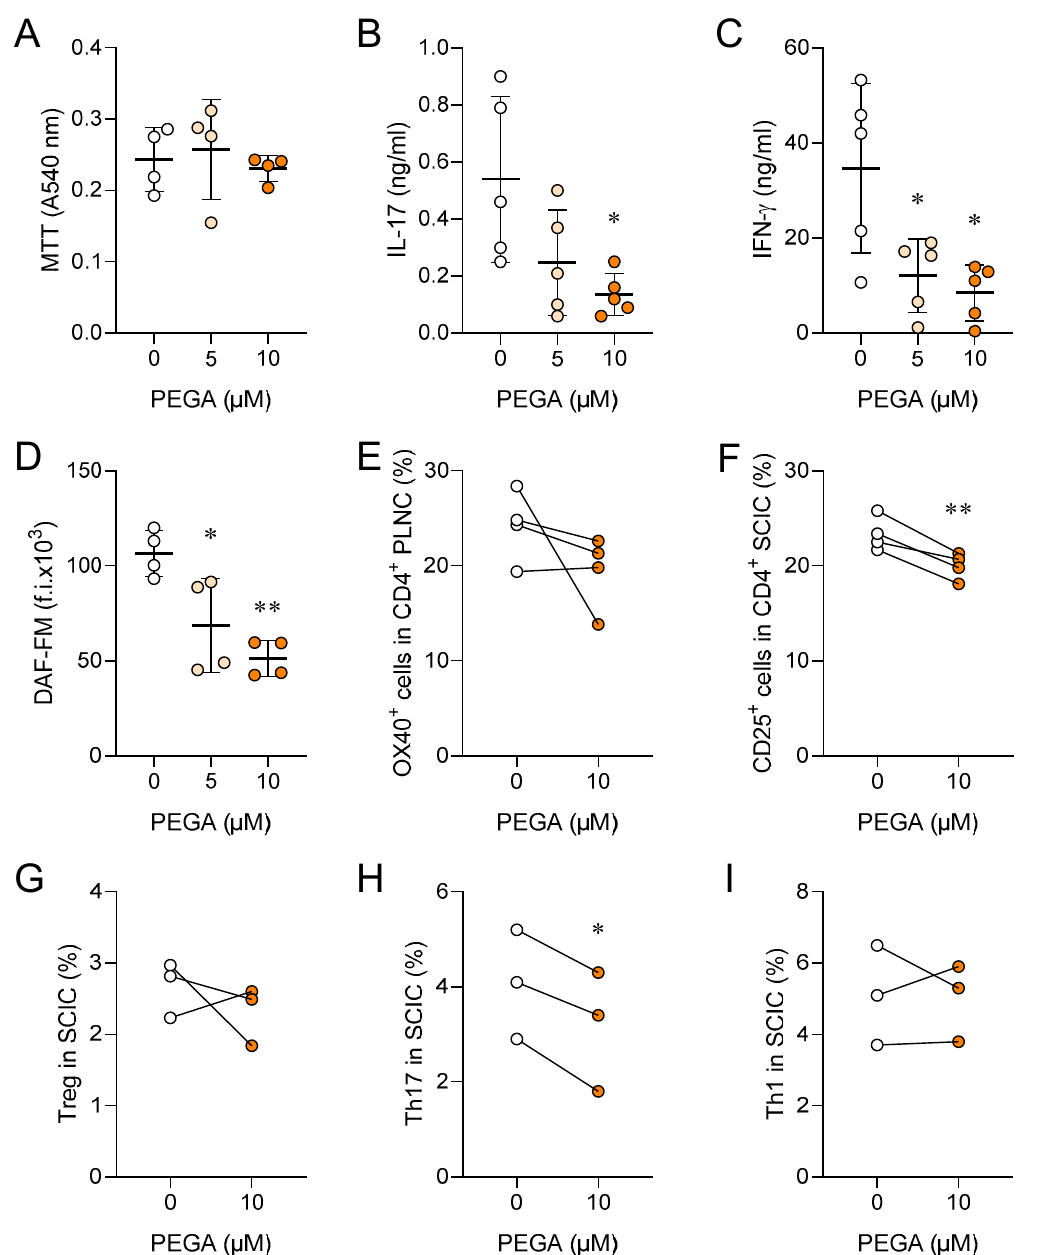
Figure 2. Immunomodulatory effects of PEGA on SCIC. Rats were immunized with SCH. SCIC were isolated on day 11 p.i. and cultivated in the absence (0) or presence of PEGA for 24 h, and cell viability was determined by MTT ( A ), cytokine levels were determined in cell culture supernatants by ELISA ( B , C ), DAF-FM was measured by fluorimetry ( D ), activation was assessed by OX40 ( E ) and CD25 staining ( F ) in CD4 + T cells by flow cytometry. Treg were identified as CD4 + CD25 + Foxp3 + cells ( G ). To determine Th17 (CD4 + IL-17 + ) and Th1 (CD4 + IFN- γ + ) cells by flow cytometry, SCIC were stimulated with PMA and ionomycin in the presence of brefeldin A for 4 h before staining ( H , I ). Individual values of 5 ( B , C ), 4 ( A , D – F ) or 3 ( H , I ) samples are presented. In addition, the mean values +/ − SD are given ( A – D ). One-way ANOVA followed by Tukey’s multiple comparison test ( A – D ), paired Student’s t -test ( E – I ), * p < 0.05, ** p < 0.01, *** p < 0.001, vs.